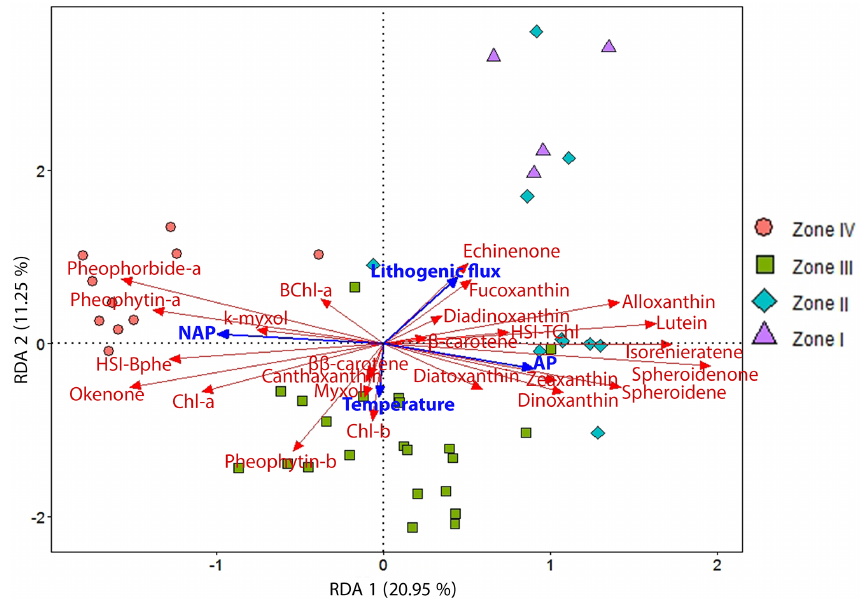
Figure 5. RDA triplot showing the explanatory variables (AP, NAP, temperature and lithogenic flux) in blue and the response variables (HPLC- and HSI-inferred pigment concentrations) in red. The samples are grouped according to the pigment zones (Fig. 4a).